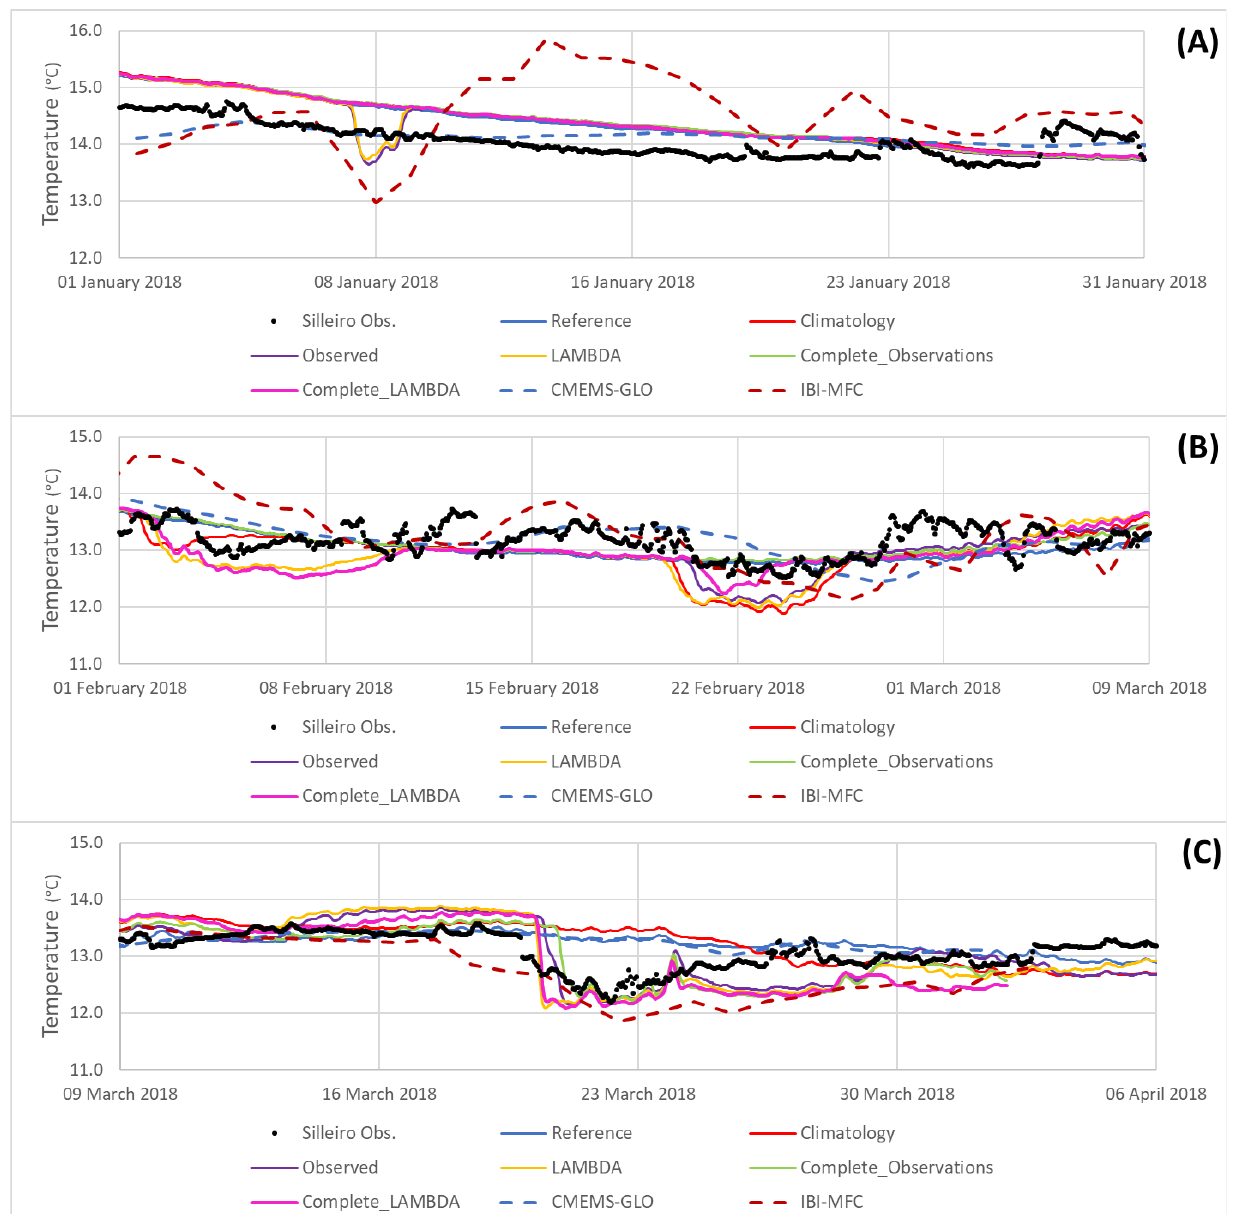
Figure 8. Sea surface temperature (black dots) and modelled at the Silleiro buoy during the first quarter of 2018. PCOMS modelling scenarios include: with no discharge (Reference, Blue line), with direct discharge (Climatology (red line), Observed (purple line), and LAMBDA (yellow line)) and with the proxy for the main six estuaries plus 45 direct discharges (Complete Observations (green line) and Complete LAMBDA (pink line)). Surface salinity from CMEMS-Global (dashed red line) and IBI-MFC (dashed blue line) regional product are also included. The analysed was divided into three sections ( A ) (January), ( B ) (February and first week of March) and ( C ) (rest of March and first week of April) for clarity. See Section 3.3 for more configuration details. Table 3. Surface salinity and temperature coefficient of determination (R 2 ), Root Mean Square Error (RMSE) and Mean Absolute Error (MAE) between the observations of Silleiro buoy and each PCOMS configuration using LAMBDA boundary conditions scenario for the period of 1 January–4 January 2018. The Complete scenarios are the only ones using the proxy. Property